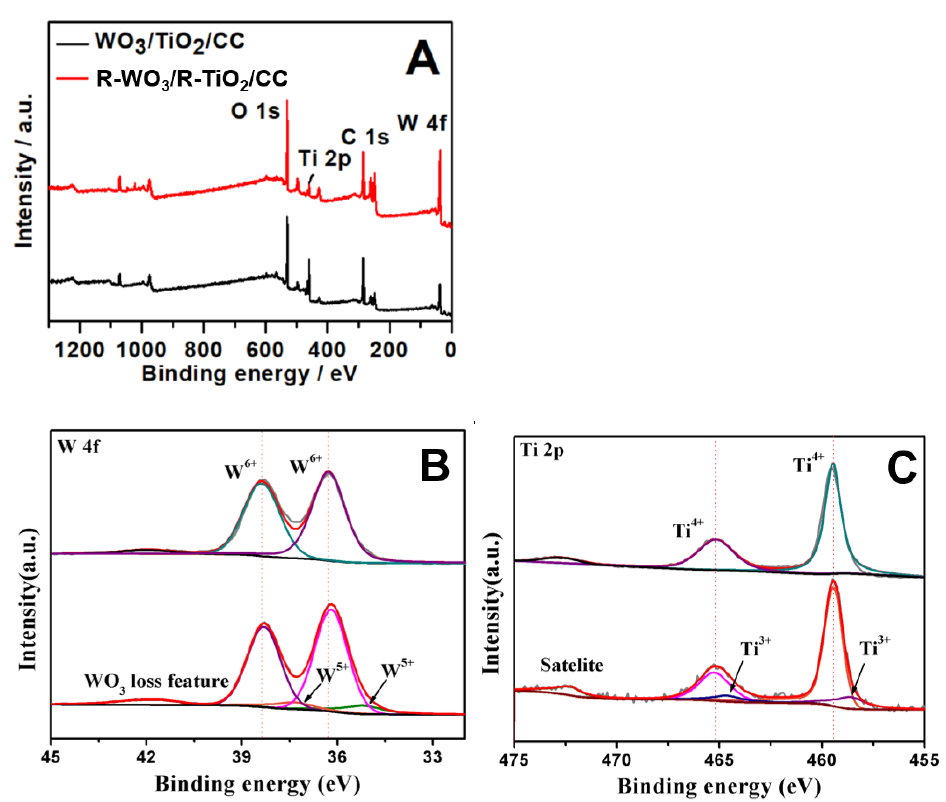
Figure 7. The XPS survey spectra ( A ), high-resolution XPS spectra of W 4f ( B ) and Ti 2p ( C ).